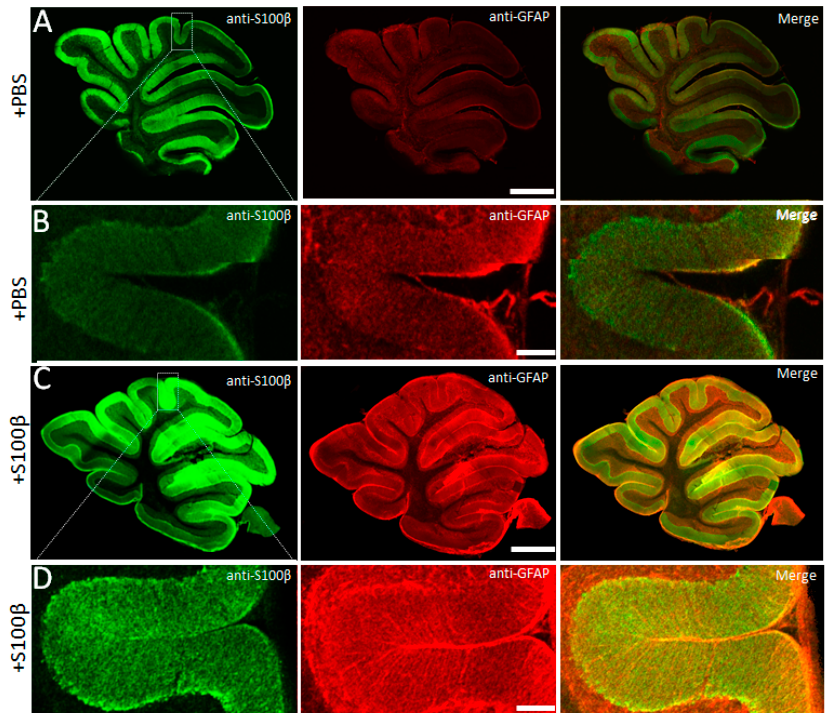
Figure 1. S100 β in mouse cerebellum. ( A ) Confocal image of a cerebellar slice injected with phosphate buffered saline (PBS). Left: anti-S100 β . Right: anti-GFAP. Scale bar 1 mm. ( B ) High power confocal image of the zone indicated on ( A ). Scale bar 100 µ m. ( C ) and ( D ) same as above, but from mice pre-injected with S100 β . Scale bar in ( C ) is 1 mm, and in ( D ) is 100 µ m.